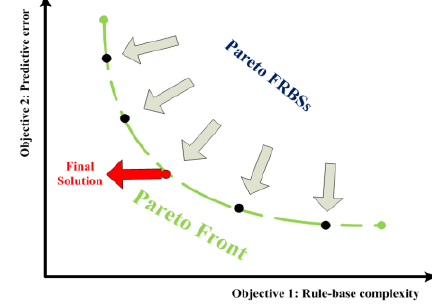
Fig. 1. Pareto front in a bi-objective fuzzy modeling